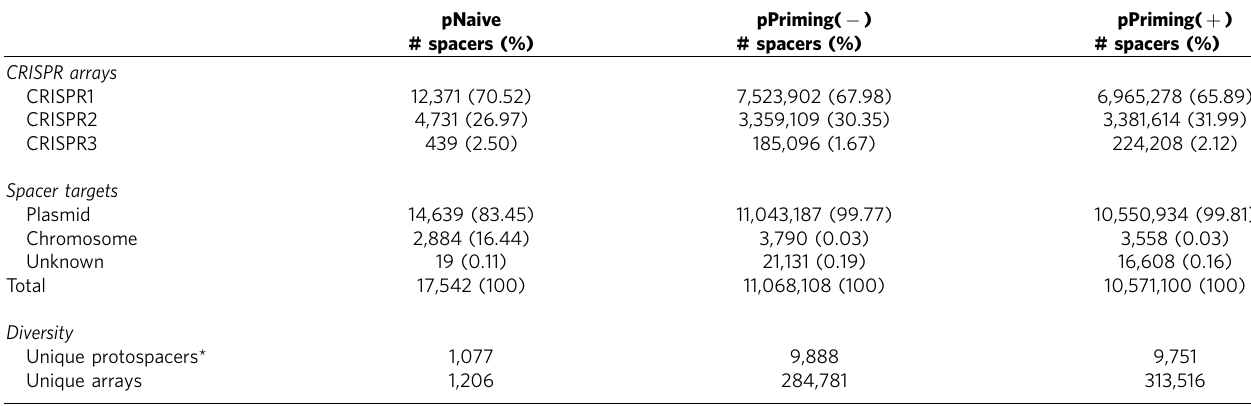
Diversity Unique protospacers*